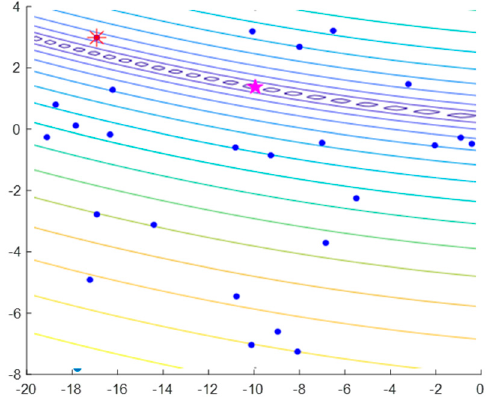
Figure 1. Bukin N. 6 landscape.